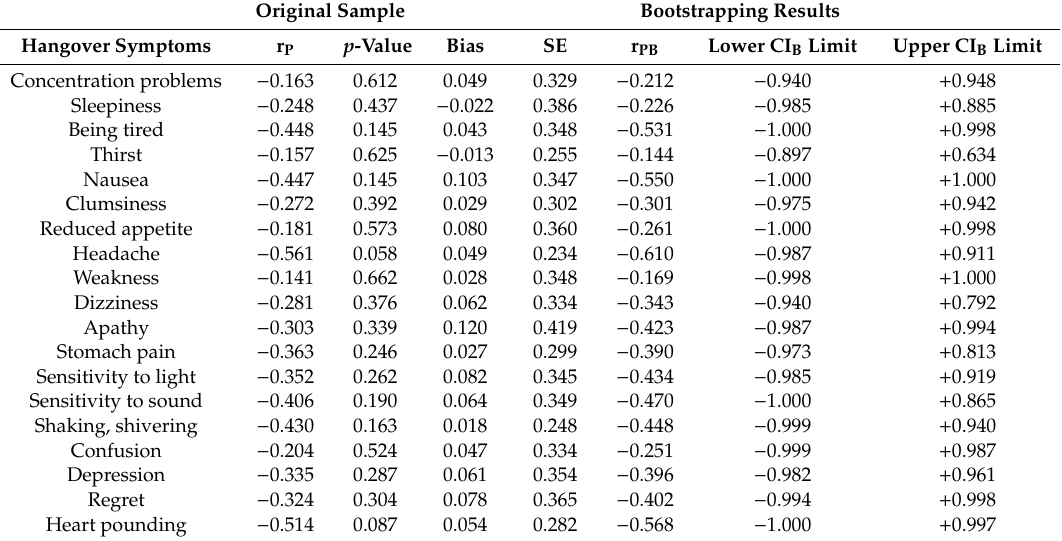
Figure 4. Hangover symptom severity. The average score across all subjects is shown for each hangover symptom in ( A ). ( B ) shows the hangover severity reported by only those subjects that endorsed the hangover symptom. Error bars represent the standard error. Association between dietary nicotinic acid intake (two-day average) and hangover symptom